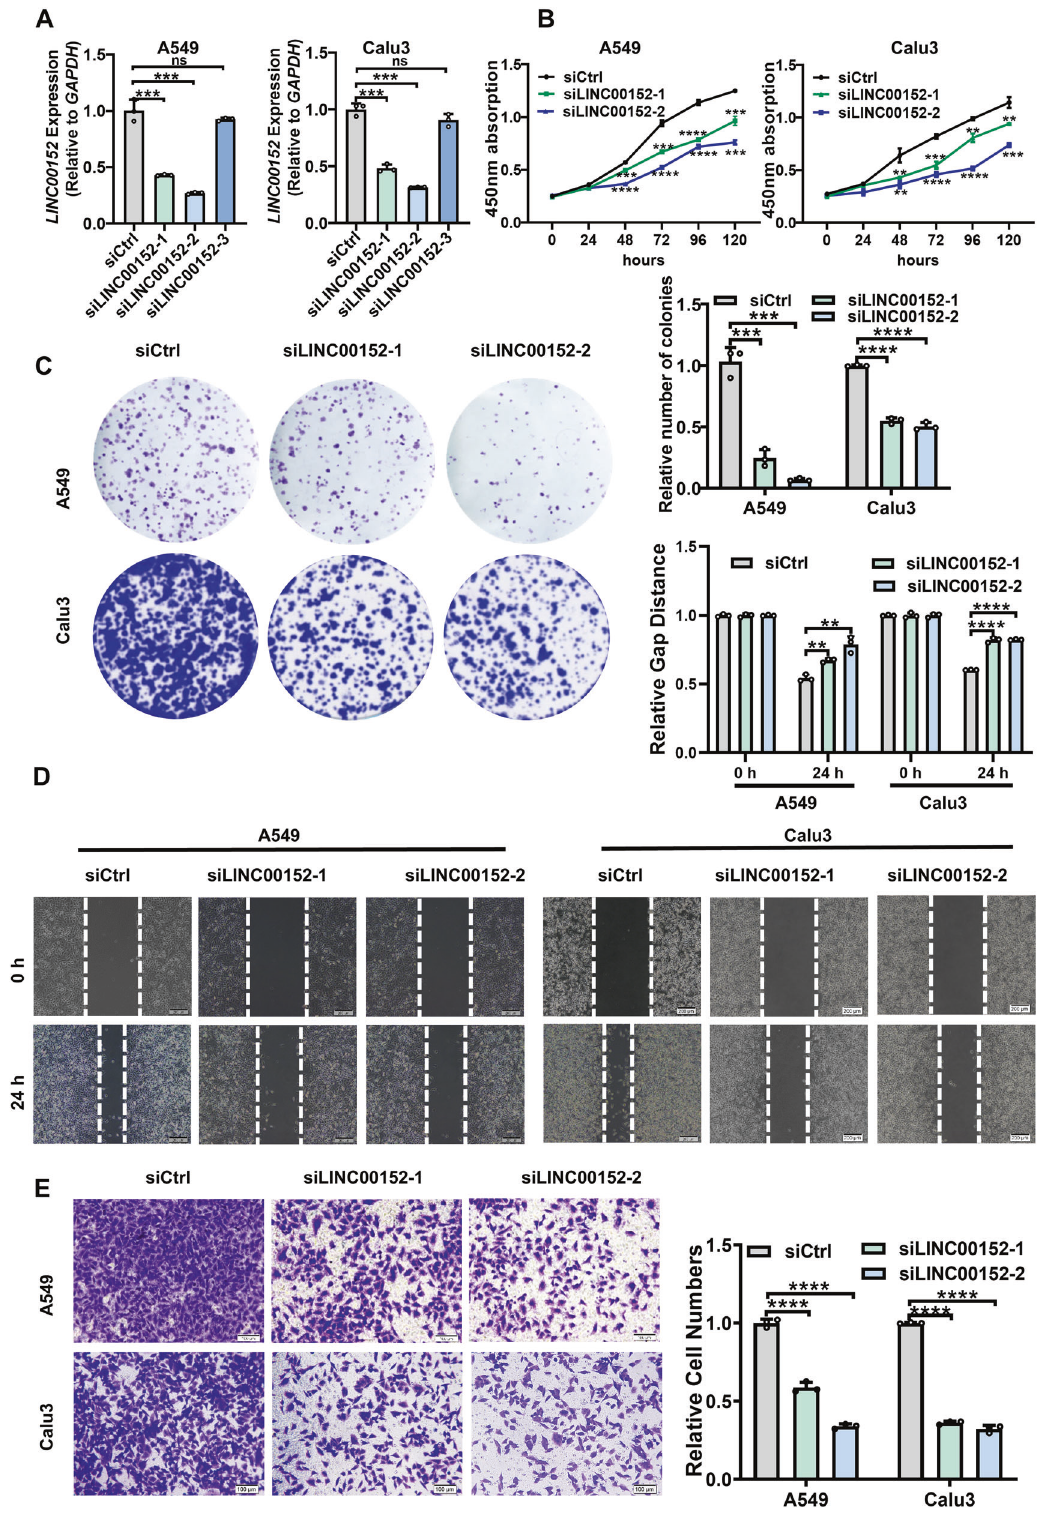
Fig. 4 Knockdown of LINC00152 inhibits the survival, invasion and migration of LUAD cells in vitro. A LINC00152 expression was detected after transfection of three small interfering RNAs (siRNA) into A549 and Calu3 cells. B Cell Counting Kit-8 (CCK-8) assays were performed in A549 and Calu3 cells silenced for LINC00152. C Silencing of LINC00152 inhibits the colony formation capability of A549 and Calu3 cells. D The migratory potential of LINC00152 knockdown together with their controls was analyzed in a wound-healing assay. Scale bar: 200 μ m. E The invasive potential of silenced LINC00152 together with their controls was analyzed by transwell assay. Scale bar: 100 μ m. Data shown are representative images or expressed as the mean ± SD of each group from three separate experiment (** p < 0.01; *** p < 0.001; **** p < 0.0001. Student ’ s t